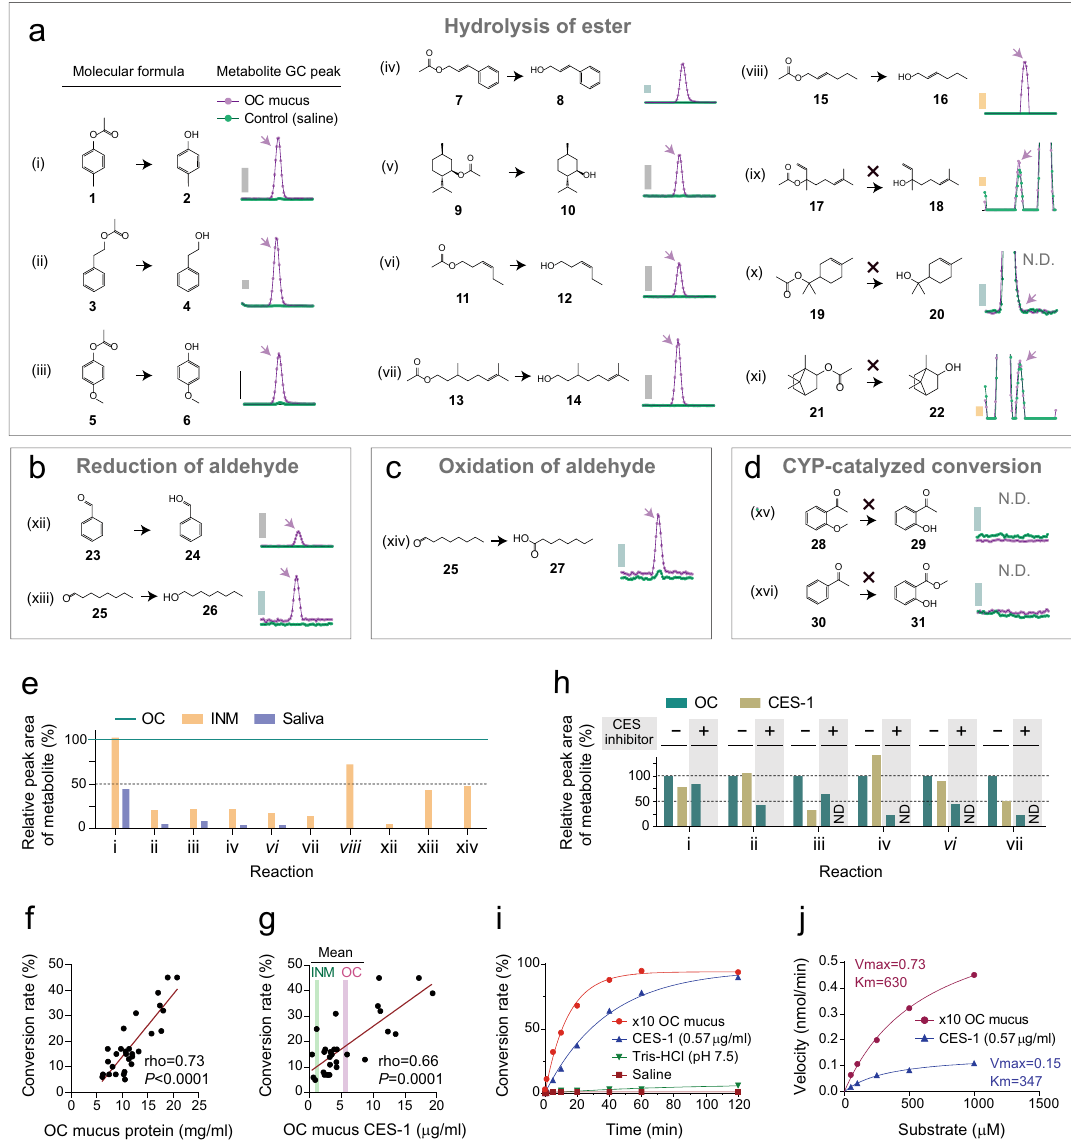
Figure 3. Enzymatic activity of the olfactory mucus. ( a–d ) Assumed enzymatic activity of olfactory cleft (OC) mucus and the detection of resulting metabolites. Odorants were incubated in saline or OC mucus. The reactant was extracted using ethyl acetate and analyzed using gas chromatography/mass spectrometry (GC/MS). Intensity of total ion or extracted ion peaks was normalized to a peak area of ester 19 , which did not undergo OC mucus-mediated conversion. Grey and blue bars represent normalized total ion intensities of 20,000 and 2000, respectively. Yellow bar represents an extracted ion intensity of 50. ( e ) Comparison of enzymatic activity of the OC mucus with inferior nasal meatus (INM) mucus and saliva. The amounts of product in each enzymatic conversion are presented as normalized values, where a peak area of metabolite in OC mucus is set to 100%. ( f ) Individual difference in enzymatic activity of OC mucus and its association with the concentration of protein. Esterase activity of individual × 10 OC mucus was evaluated based on a conversion rate as [ p -cresol (mol)]/([ p CA (mol)] + [ p -cresol (mol)]) 5 min after p -cresyl acetate ( p CA) was applied to OC mucus (n = 29). ( g ) Association between esterase activity and carboxylesterase 1 (CES-1) concentration in OC mucus (n = 29). Green and magenta lines denote mean values of INM and OC mucus, respectively. ( h ) Substrate selectivity of OC mucus and CES-1. Recombinant CES-1 did not show identical reactivity with OC mucus. OC mucus showed residual activity under CES inhibitors (bis(4-nitrophenyl) phosphate), which completely inhibited CES- 1. Inter-sample variability of the detected peak area was corrected using the peak area of non-metabolized ester 19 . ( i ) Time course of the conversion rate from p CA to p -cresol in × 10 diluted OC mucus or CES-1 solution. The reaction proceeded linearly up to 5 min after the addition of p CA in the ten-fold diluted OC mucus and up to 40 min in the CES-1 solution. ( j ) Michaelis–Menten plot of p CA metabolism in × 10 diluted OC mucus or CES-1 solution. Various concentrations of p CA were added, and the conversion rate was measured at each time. ND, not